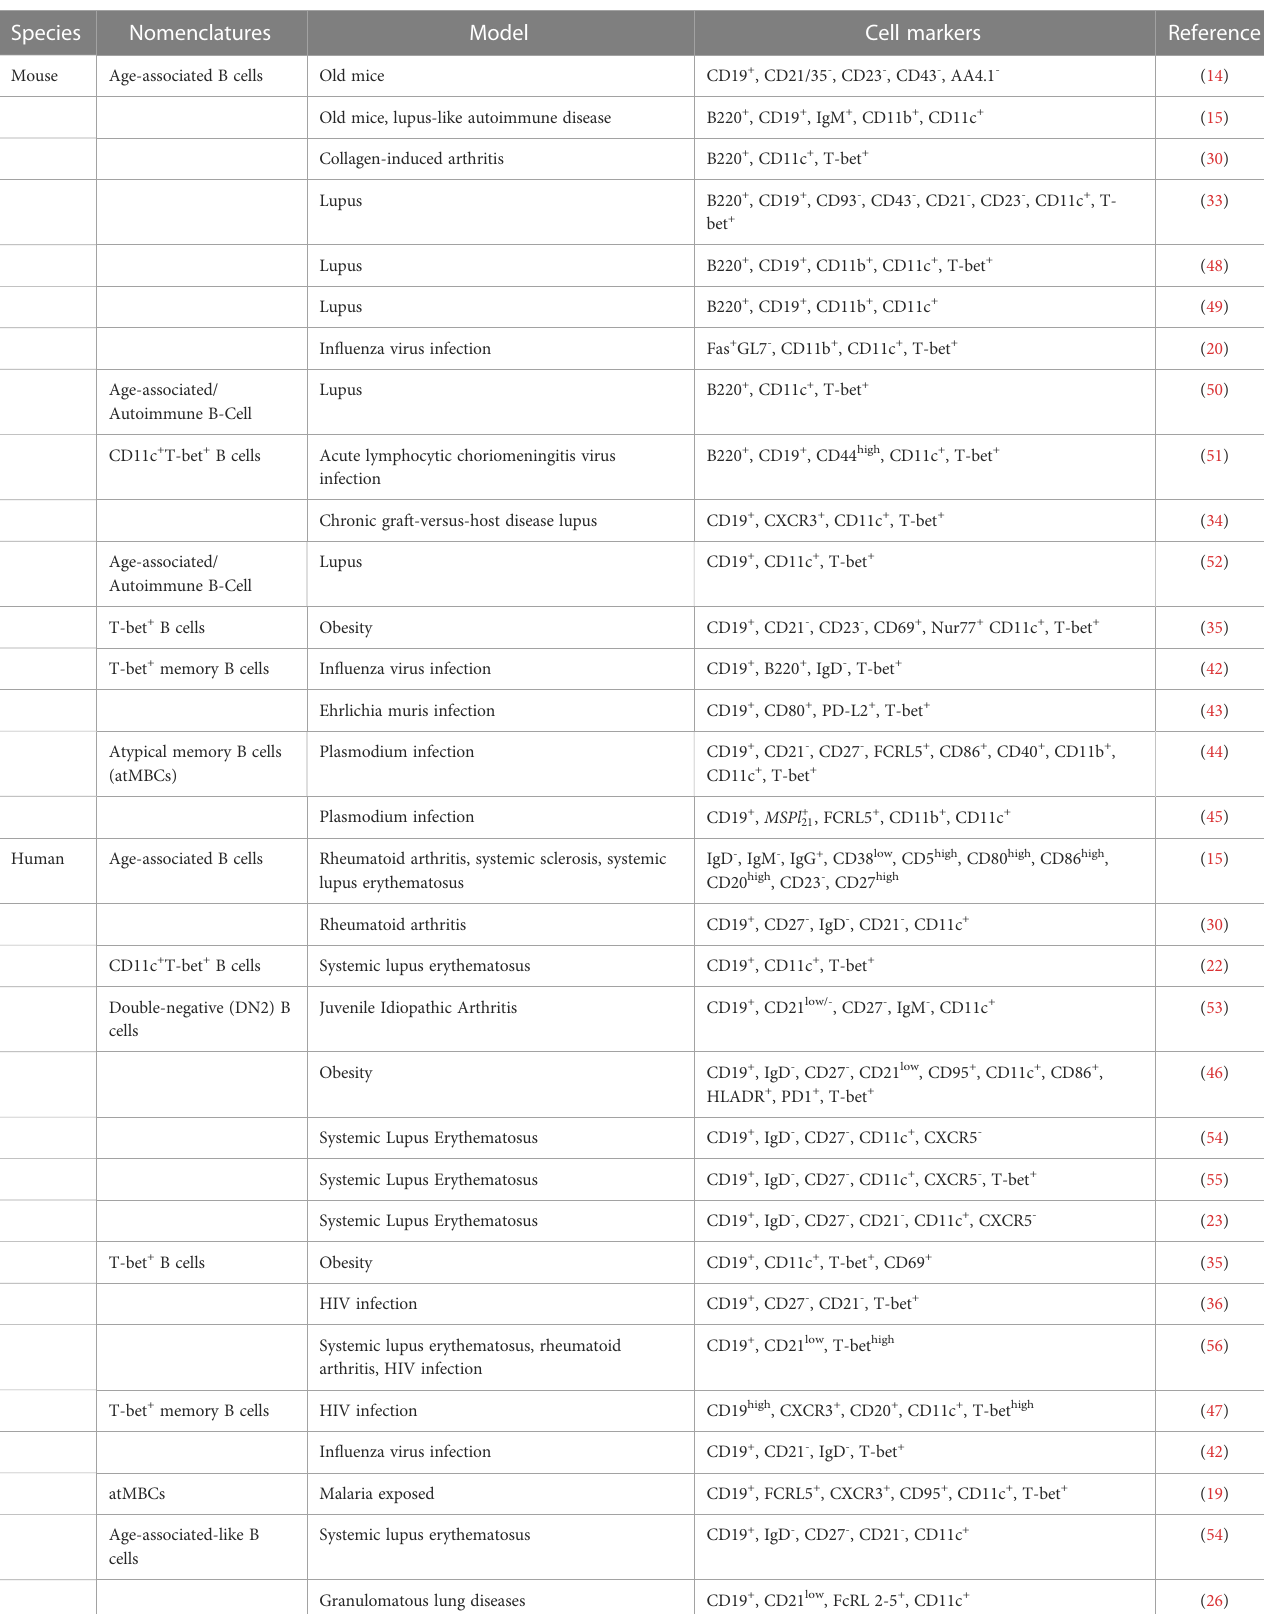
TABLE 1 Diverse nomenclatures used to describe ABCs and ABC-like